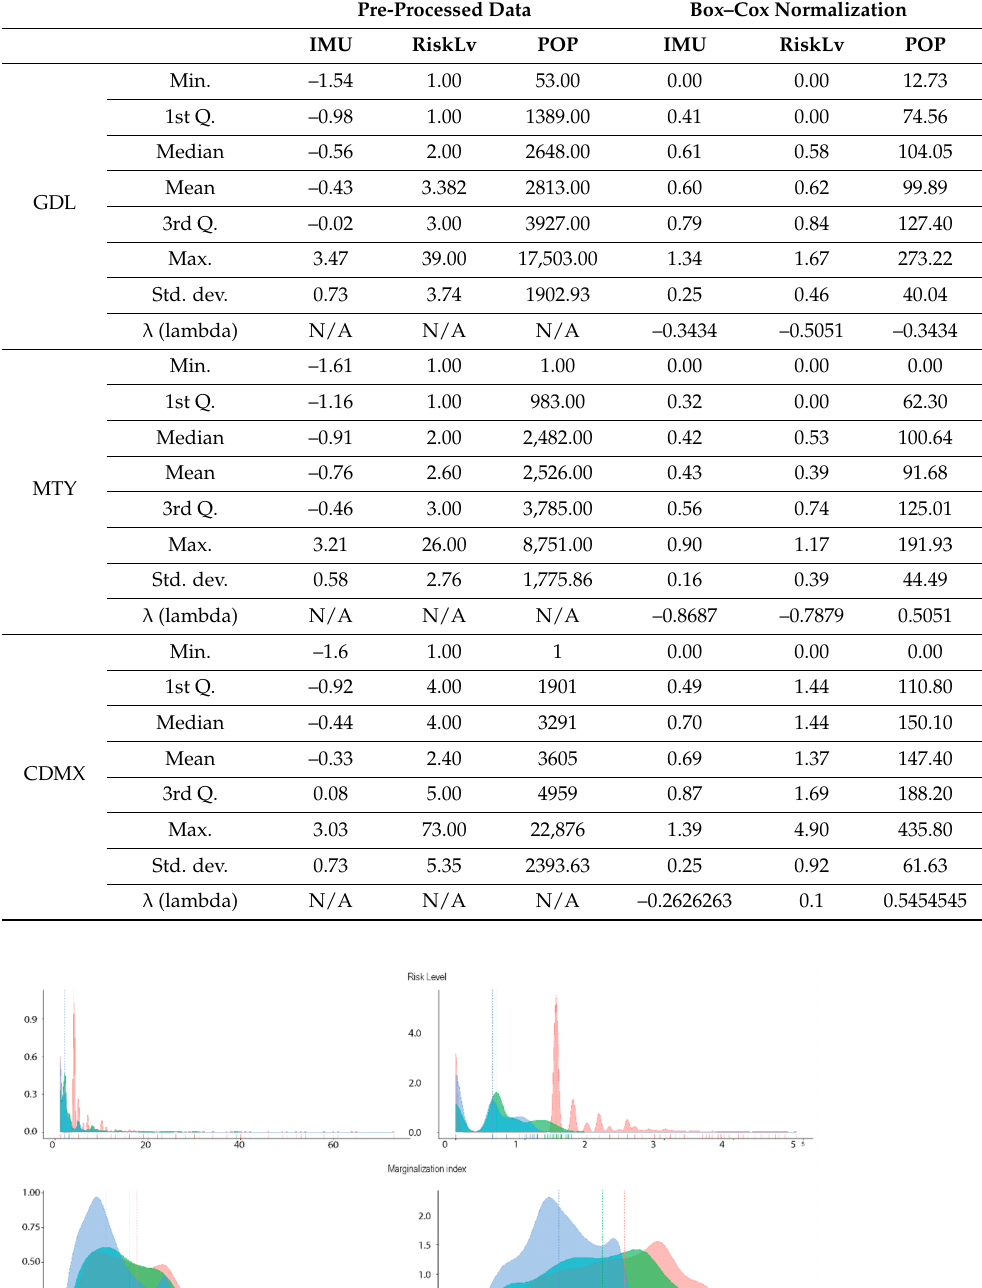
Table 6. Descriptive statistics of analyzed variables and their normalization process for Guadalajara (GDL), Monterrey (MTY), and Mexico City (CDMX).